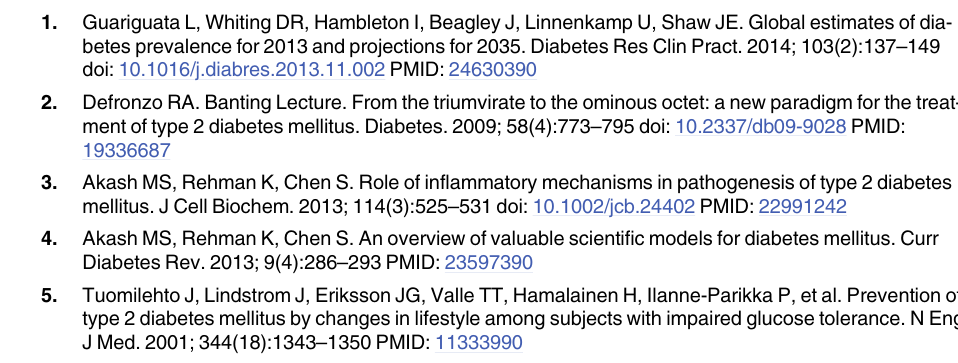
S1 Table. Characteristics of the diabetes risk scores S2 Table. Area under the receiver operating characteristic curve of diabetes risk scores in men and women S3 Table. Univariate and multivariate logistic regression analysis of laboratory